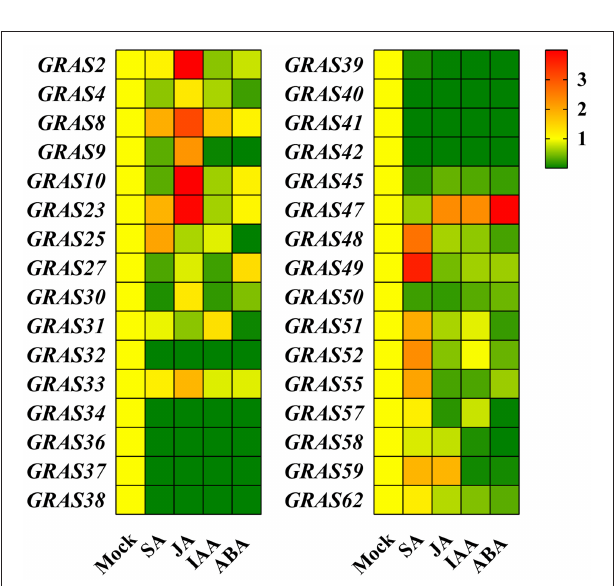
FIGURE 3 | The GRAS genes expression pattern in different tissues of Brachypodium distachyon . The expression level of the BdGRAS gene in the root, stem, leaf, and seeds of B. distachyon , using UBC as a control.